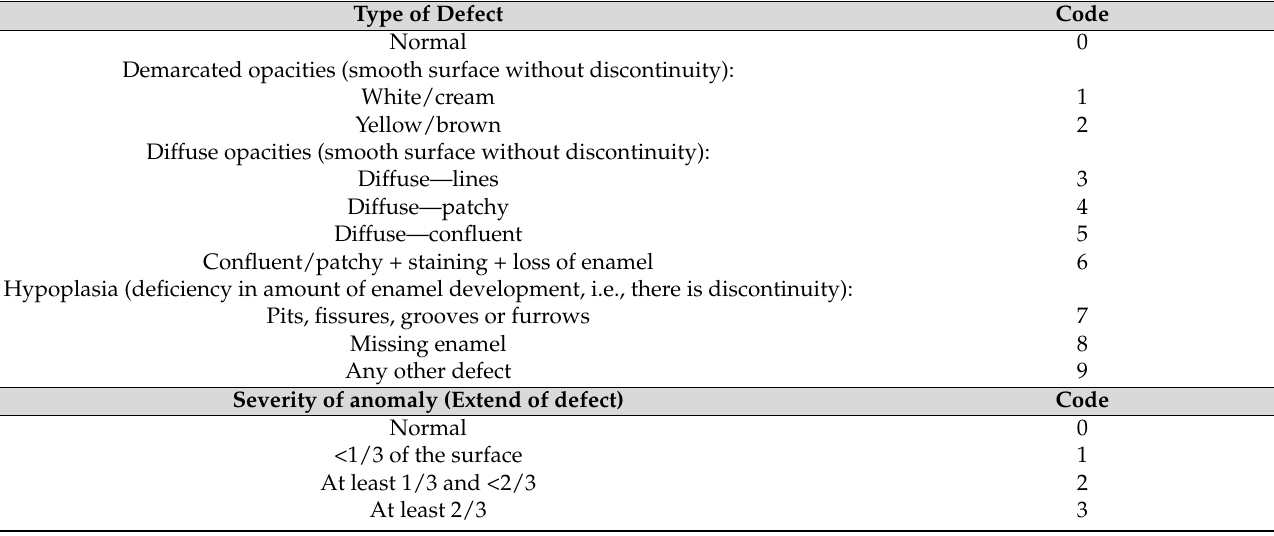
Table 1. Scoring system of the Modified Developmental Defects of Enamel (DDE) Index for epidemi- ological studies